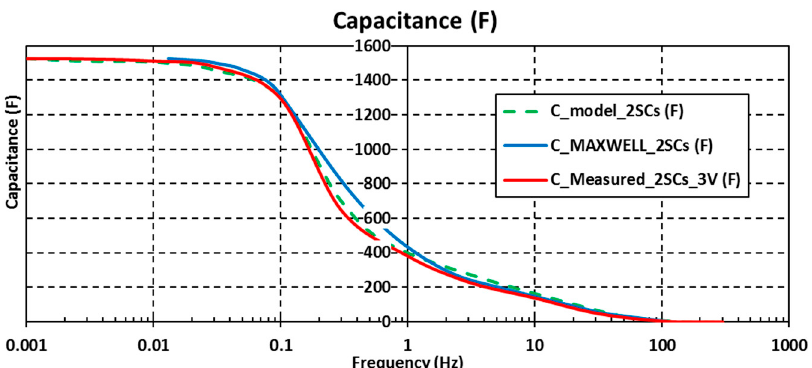
Figure 18. Comparison in the frequency response of the measured capacitance and the electrical circuit model capacitance of the two SCs charged to 1.5 V. The evolution as per the manufacturer is shown in blue.